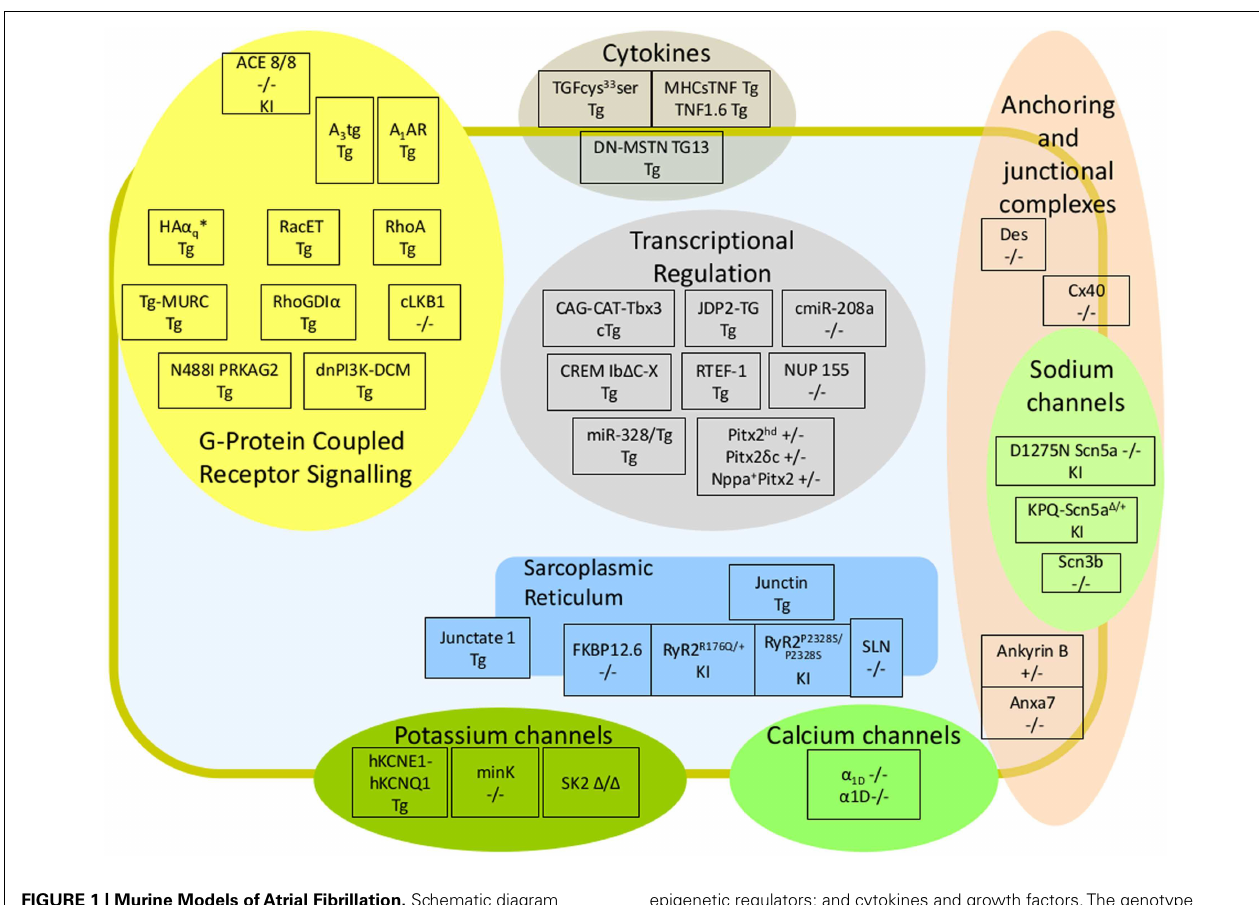
FIGURE 1 | Murine Models ofAtrial Fibrillation. Schematic diagram depicting murine models of atrial arrhythmia within the context of arrhythmic signaling pathway and subcellular localization. Models were subdivided into altered G-Protein Coupled Receptor signaling; altered ion channels dynamics, anchoring, and junctional complexes; altered calcium homeostasis; altered transcriptional, post transcriptional, and